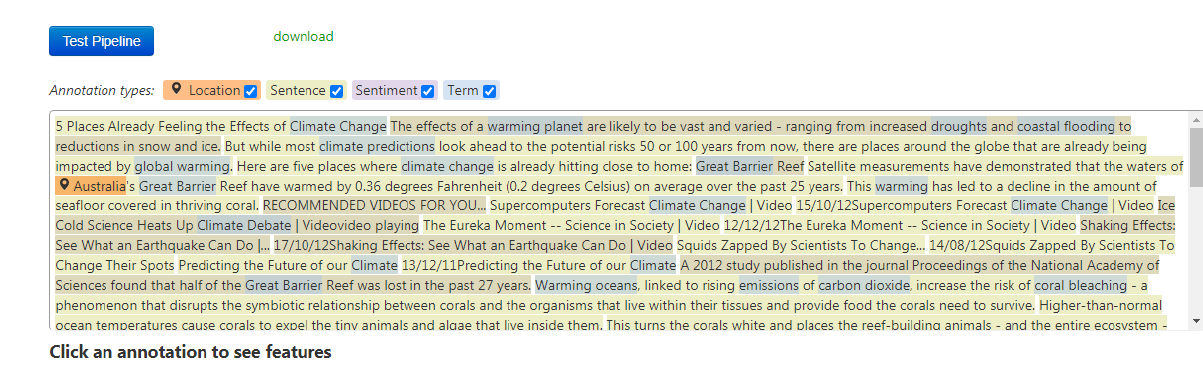
Figure 3 . Results of the “DecarboNet Environmental Annotator” Process.